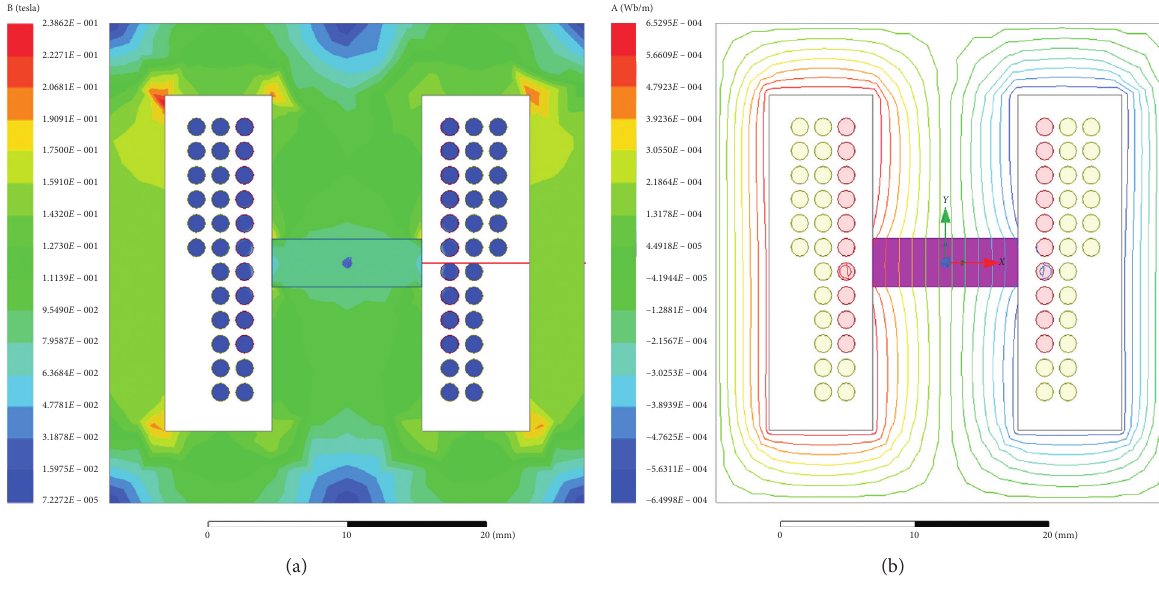
Figure 8: FEM. (a) Magnetic flux density. (b) Magnetic flux